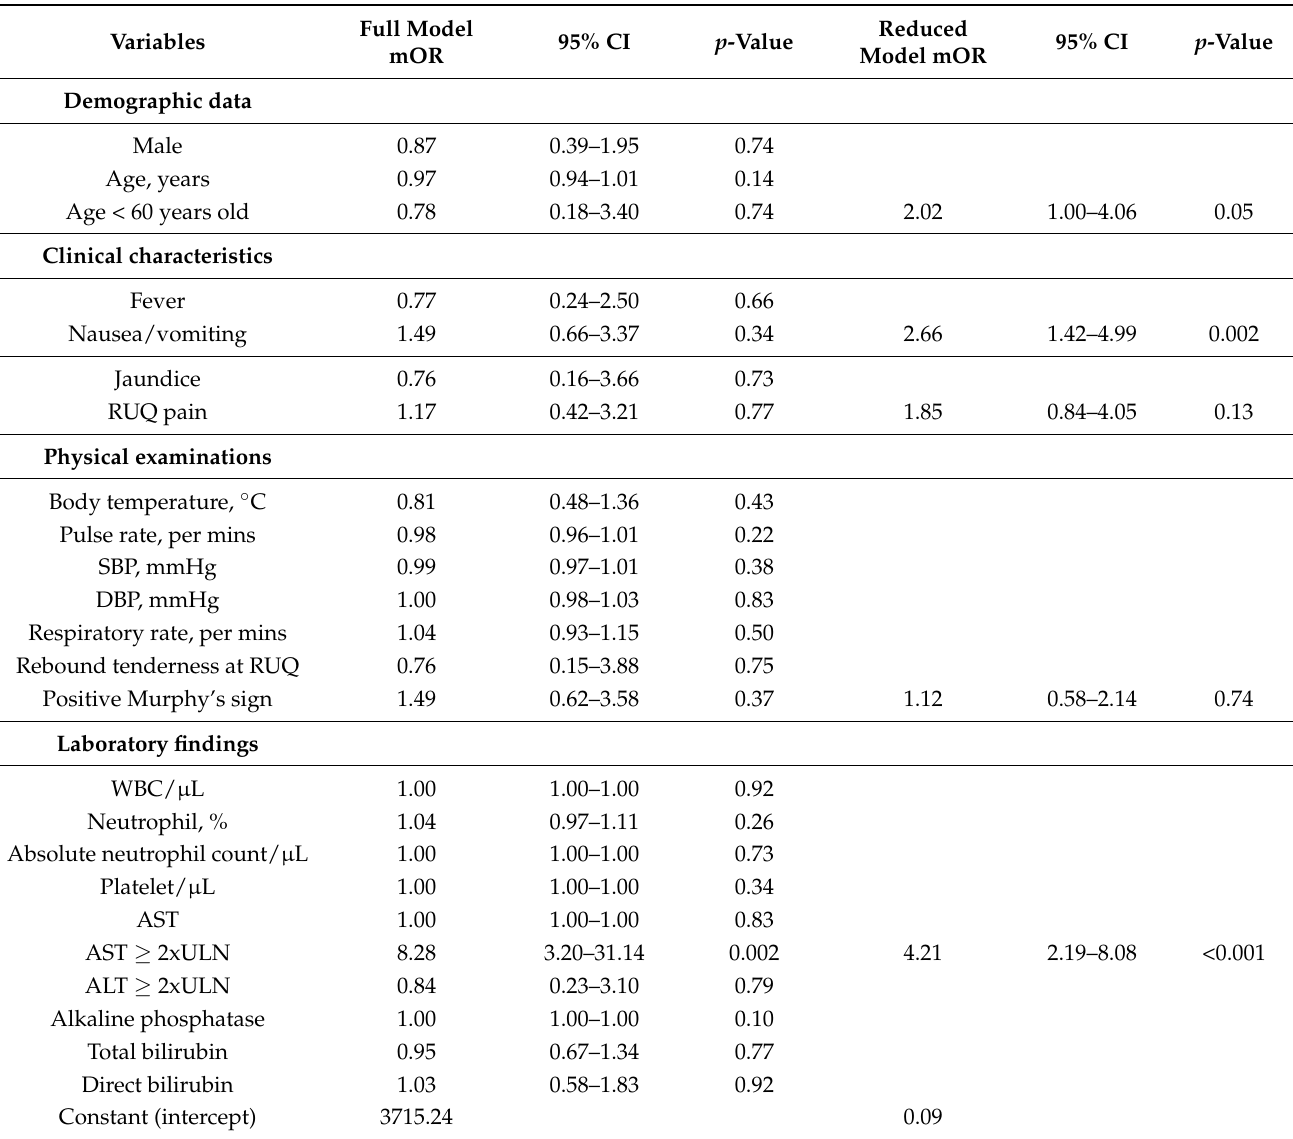
Table 2. Multivariable logistic regression analysis.